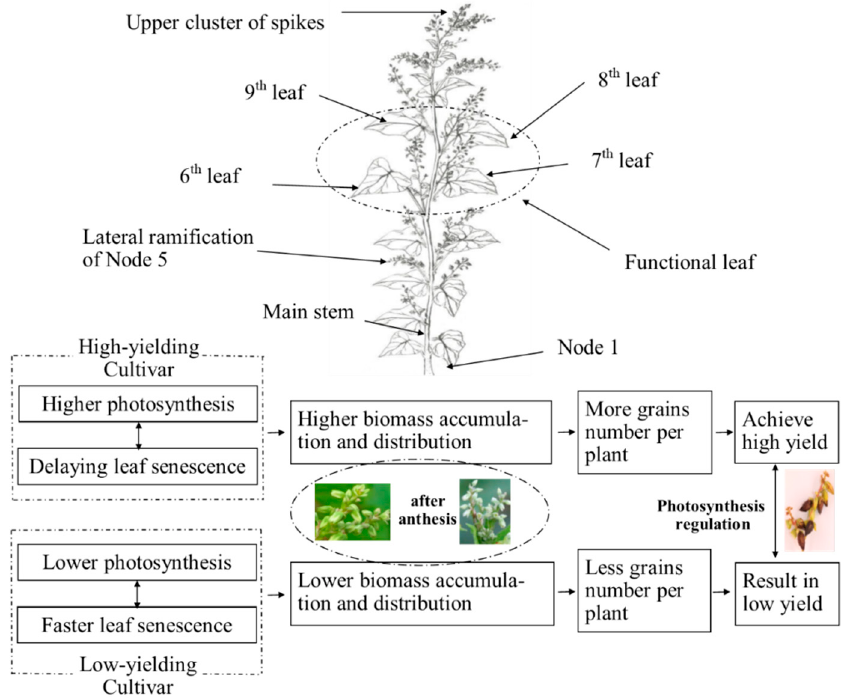
Figure 7. Schematic of plant structure and some factors underlying the performance of high- and low-yielding cultivars of Tartary buckwheat.